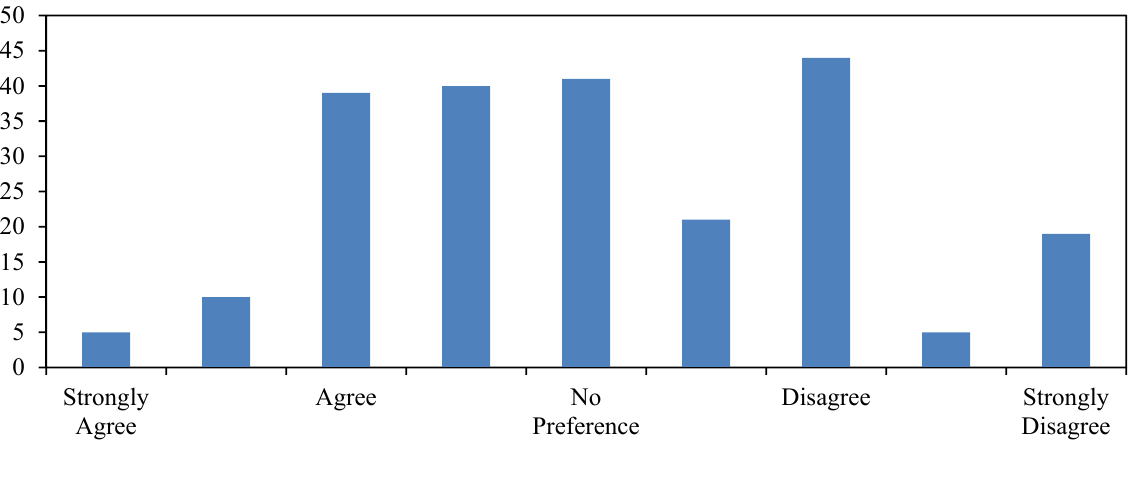
Figure 14. Graph of responses to the statement “I would trust a scientific finding that was arrived at by a computer